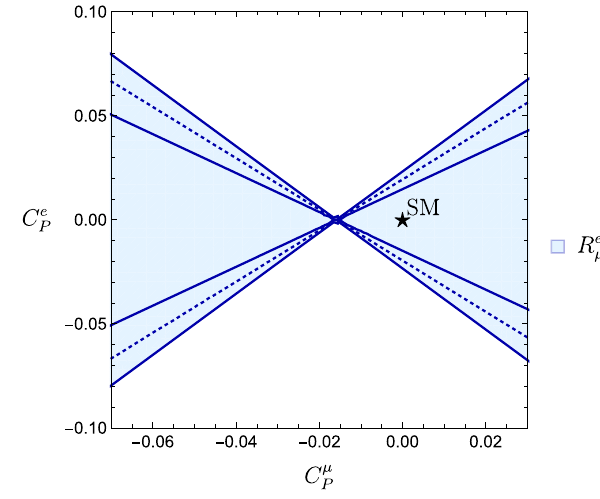
μ – C e plane following from the lep- P P